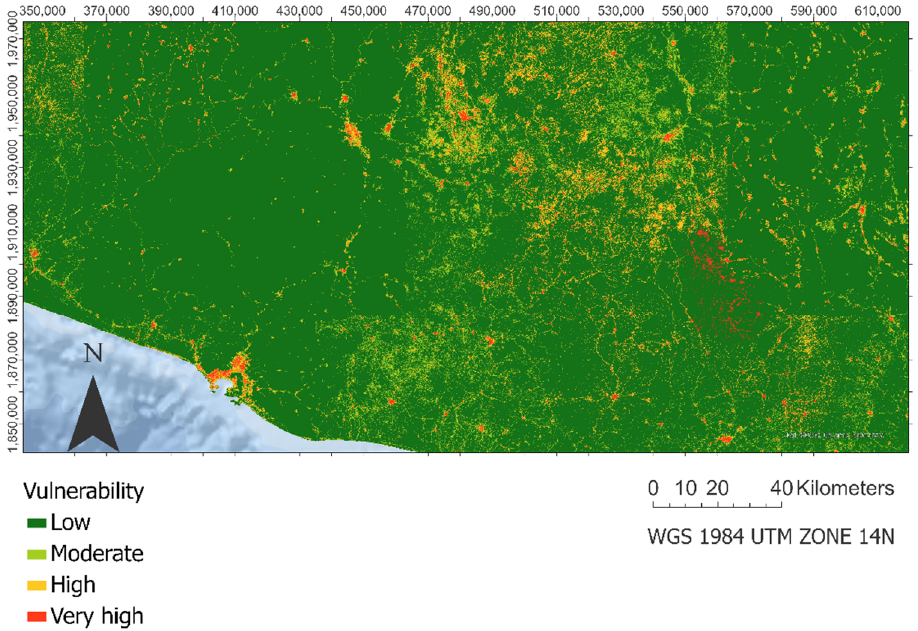
Figure 4. Landslides socio-economic vulnerability.